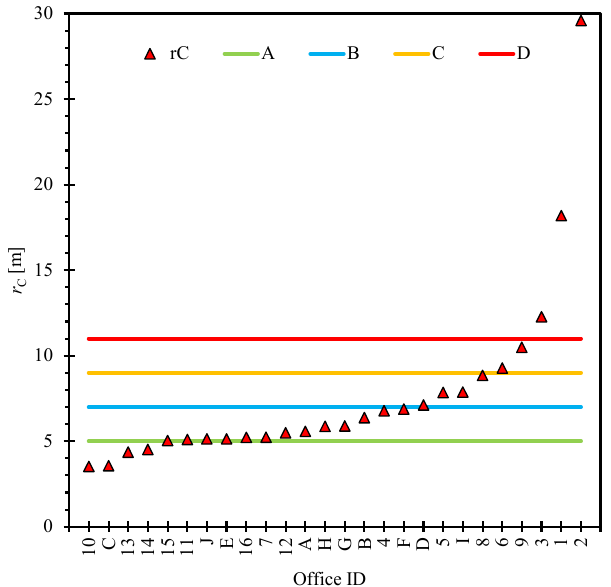
Figure 7. Rank ordered comfort distance, r C , as a function of office ID (red triangles) for the 26 offices of Table 1. The proposed limits for classes A–D are indicated by horizontal lines. The figure expects that L p,A,C = 45